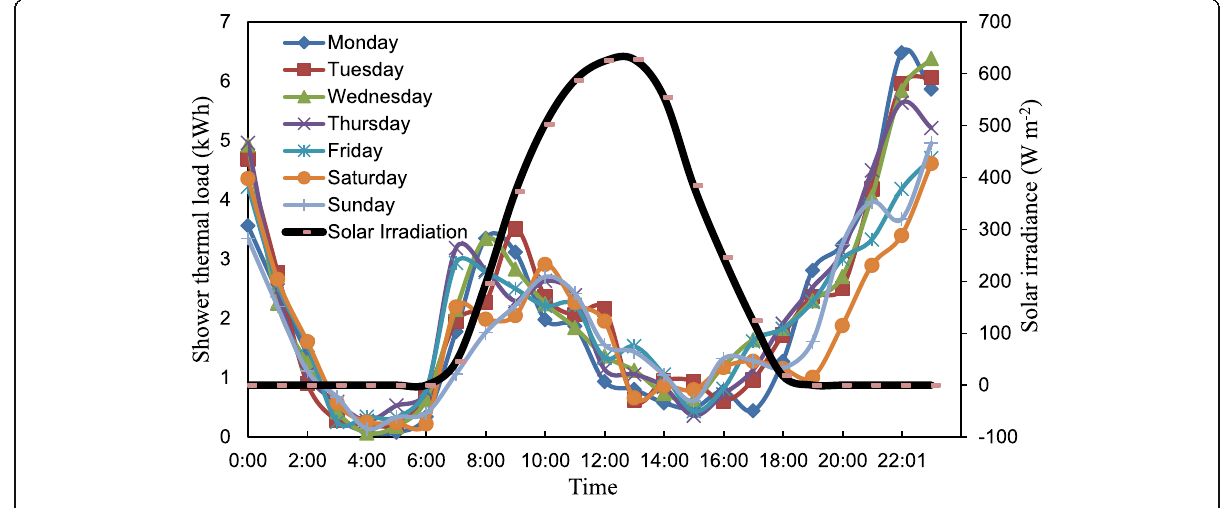
Fig. 8 Typical variation of thermal load (hot water shower) during a day